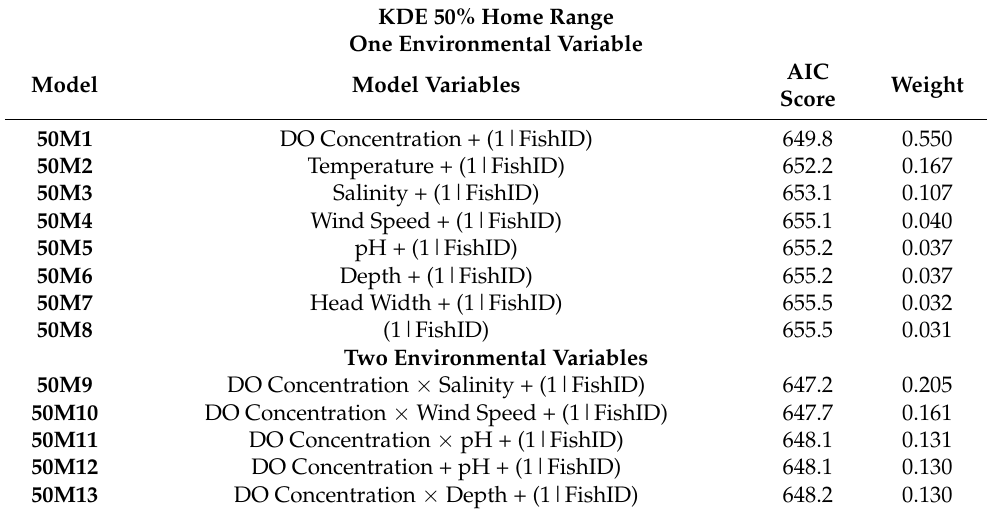
Table A2. Generalized linear mixed effect models used to explain KDE home range areas and daily distance traveled.